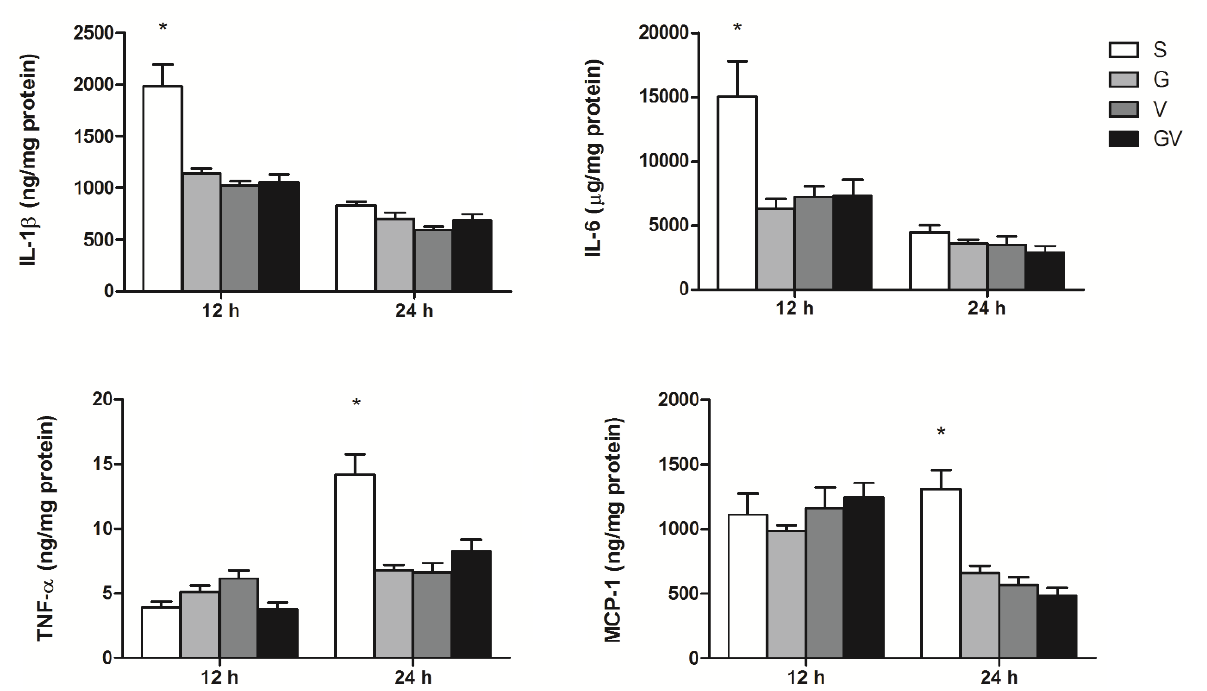
Figure 1. Concentrations of inflammatory mediators in peritoneal lavage fluid after cecal ligation and puncture (CLP) at two time points. IL-1 β , interleukin-1 β ; IL-6, interleukin-6; TNF, tumor necrosis factor; MCP, macrophage chemoattractant protein; S, sepsis group without vitamin D (VD) before or after CLP; G, sepsis group with cholecalciferol gavage before CLP; V, sepsis group with an intravenous calcitriol injection after CLP; GV, sepsis group with both cholecalciferol before and intravenous calcitriol after CLP ( n = 8 in each group). Data are presented as the mean ± standard error of the mean (SEM). Differences among groups at the same time point were analyzed by a one-way analysis of variance using Tukey’s post hoc test. * Significantly differs from the other groups at the same time point ( p < 0.05).